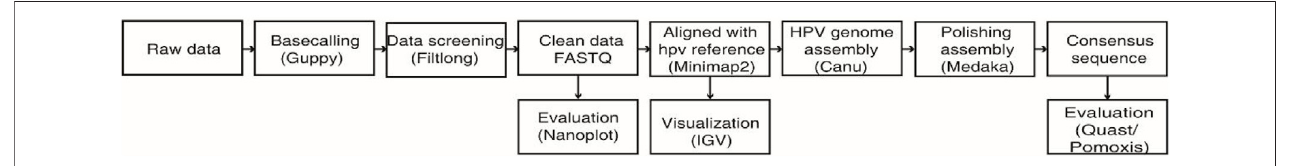
FIGURE 1 | Work fl ow chart of bioinformatic analysis and de novo assembly of the HPV genome from nanopore sequencing